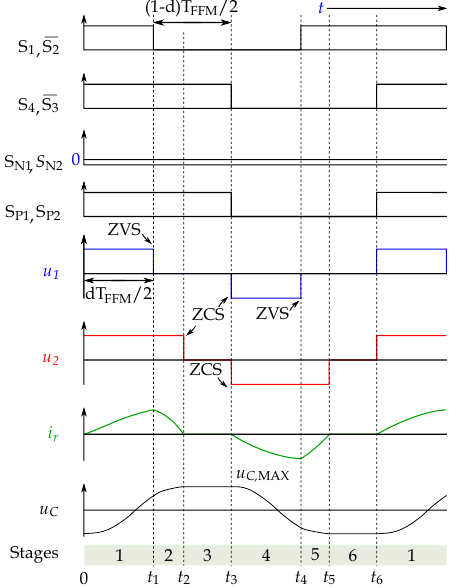
Figure 2. Key waveform of the proposed converter with